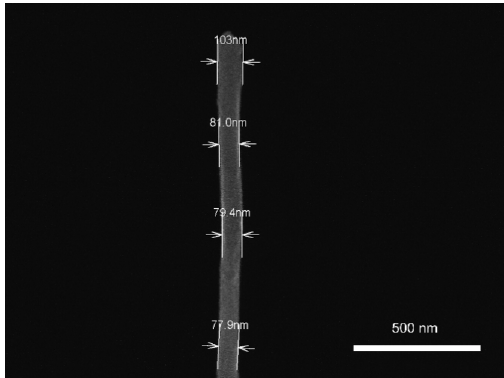
Figure 7. SEM image of a MWCNT showing the thickness collected at four different points of the fiber for the determination of the average diameter (Hitachi, SU8030).